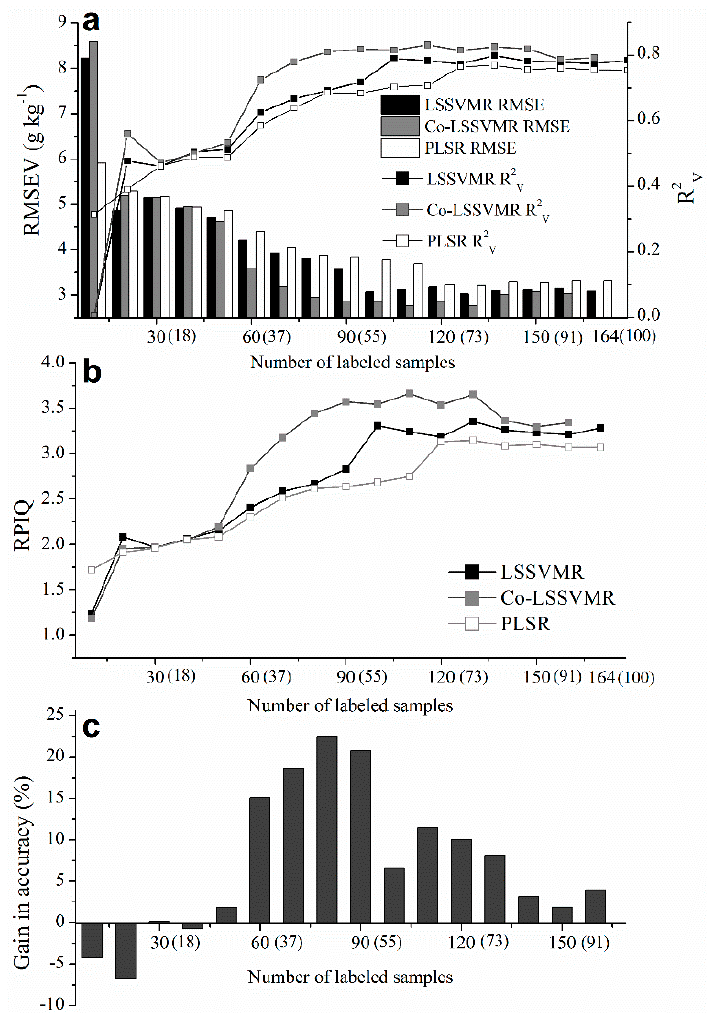
Figure 8. The performance of LSSVMR and Co-LSSVMR ( a ); ratio of inter-quartile range to RMSEV (RPIQ) of LSSVMR and Co-LSSVMR ( b ); and the gains in accuracy obtained by Co-LSSVMR with respect to LSSVMR ( c ) versus the number of labeled samples and its percentage (in brackets). For comparison, the estimation results obtained by PLSR are also plotted in ( a , b ).